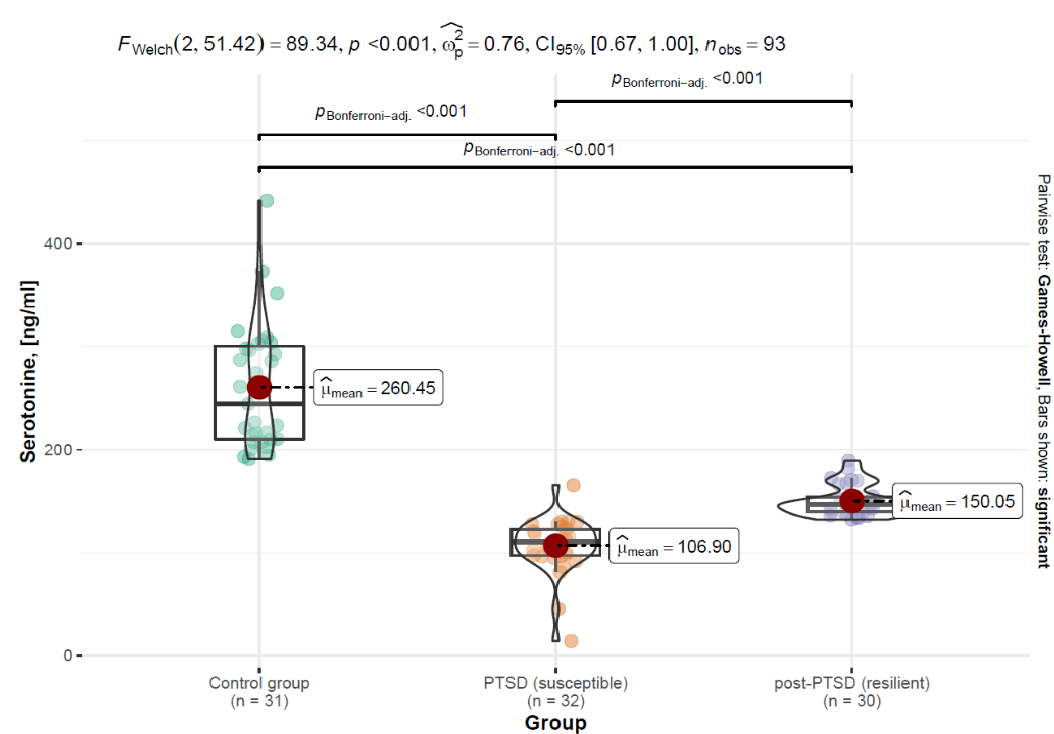
Figure 1. Distribution of the serotonin variable by patient groups in the form of a violin plot, including statistical tests and differences between the groups. Table 2. Descriptive statistics of the variables with the use of ratio and interval scales by study groups. CONTROL